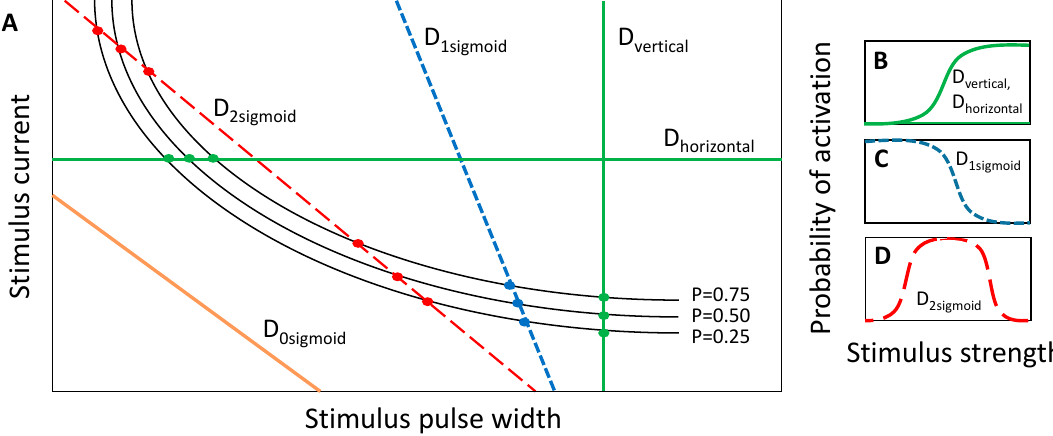
Figure 4. ( A ) Cartoon depiction of vertical (D vertical ), horizontal (D horizontal ), and negatively-sloped cross sections (D 0sigmoid , D 1sigmoid , D 2sigmoid ) through the strength–duration waveform space; ( B ) The vertical and horizontal slices cross the set of SD curves once, which is modeled by a positively sloped sigmoid. ( C , D ) The negatively-sloped slices can cross the set of SD curves either zero times (model not shown), which produces a zero probability of firing across the range of stimulus inputs; one time ( C ); which is modeled by a single negatively-sloped sigmoid; or two times ( D ); which is modeled by a probability space comprising a lower-threshold positively-sloped sigmoid and a higher-threshold negatively-sloped sigmoid.